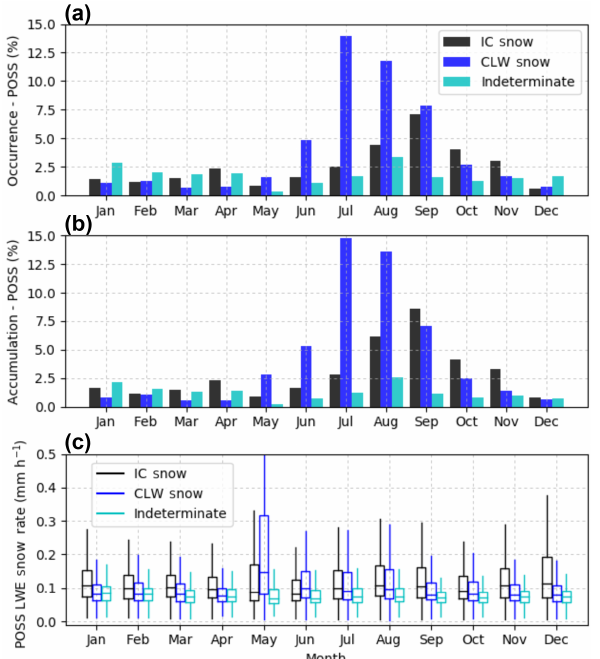
Figure 5. Panel (a) shows the average annual PWV as a func- tion of the month for MWR data from 2010–2015. The PWV values during snowfall events, regardless of type, are higher than that of the PWV averages during all times (precipitation and non- precipitating). Panel (b) shows the average PWV associated with each MWR-determined type of snowfall. Panel (c) shows the ratio of the average snow rate measured by the POSS in LWE mmh − 1 to the associated PWV in mm, thus giving a rate of how efficiently the PWV converts to precipitation for each month and snow